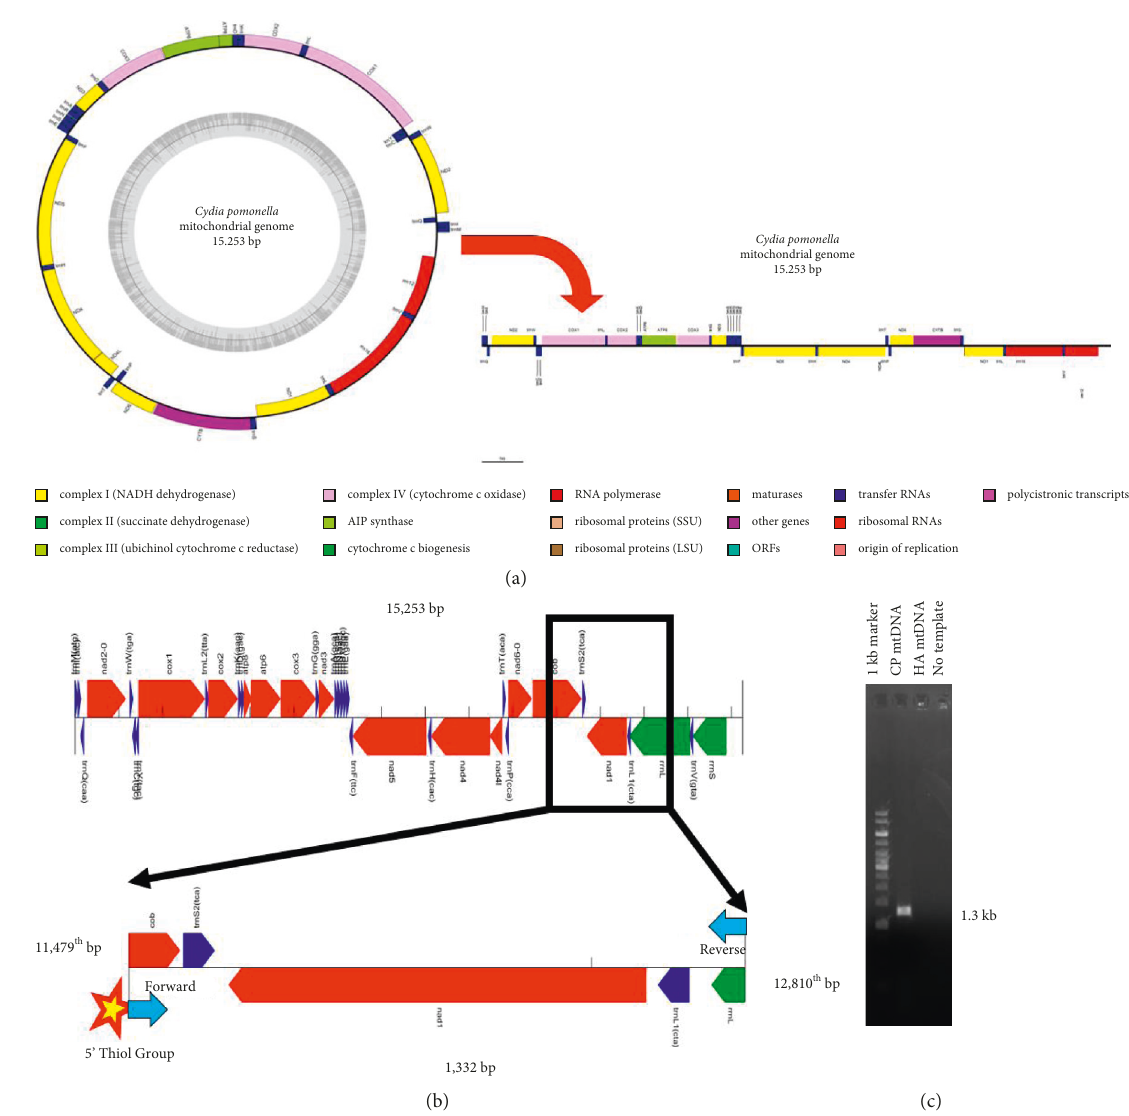
Figure 1: Designing and characterization of oligonucleotide probe. (a) Circular and linearized maps of mitochondrial genome of codling moth Cydia pomonella . (b) Designing of oligonucleotide probe and PCR primers. (c) Gel showing PCR product at 1.3kb in case of mitochondrial DNA of Cydia pomonella (CA mtDNA). Helicoverpa armigera mitochondrial DNA (HA mtDNA) was used as negative